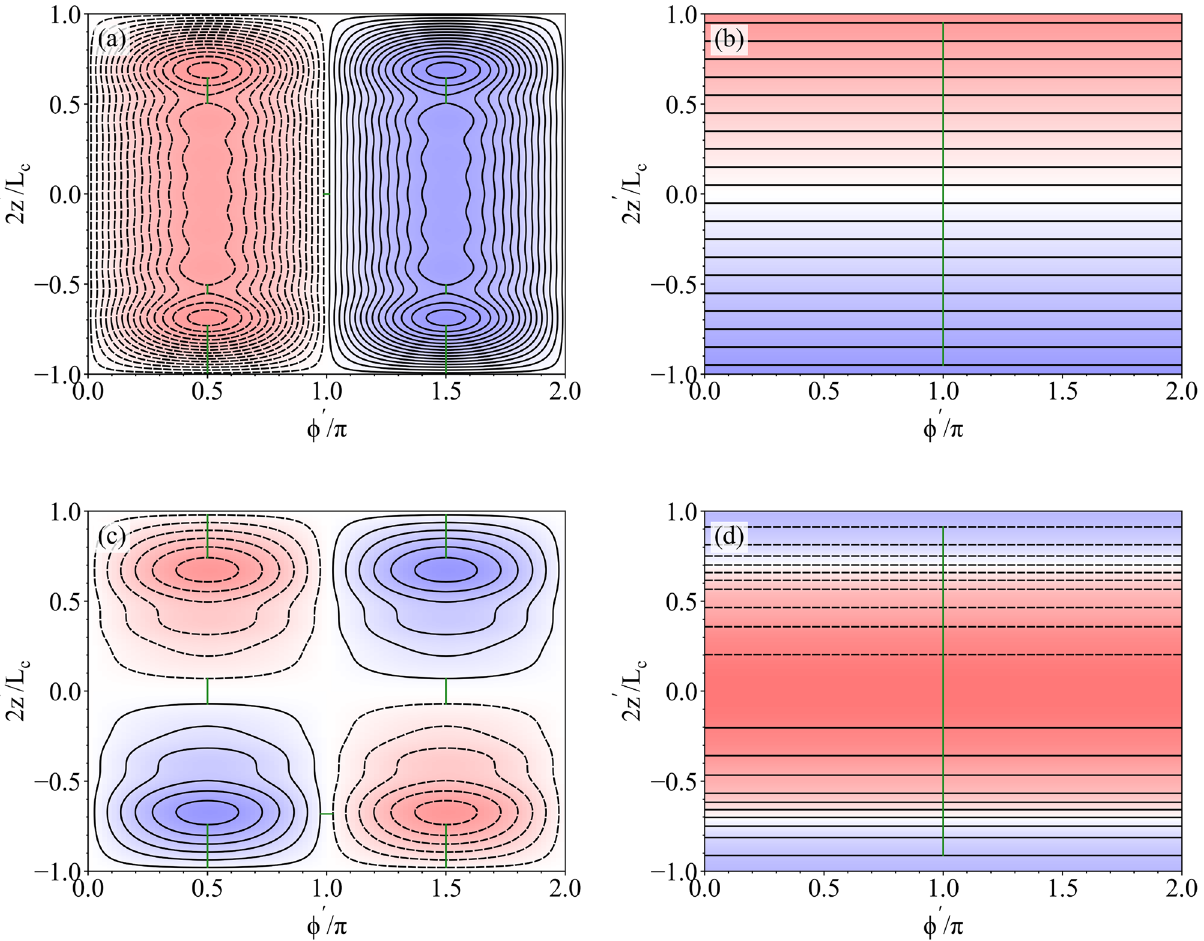
Figure 4. Normalised streamfunctions, calculated using Eq. (4), of the ( a ) uniform transverse field B x , ( b ) uniform axial field B z , ( c ) constant linear transverse field gradient d B x / d z , and ( d ) constant linear axial field gradient d B z / d z coils, respectively, on the surface of the coil former of length L c (blue and red shaded regions correspond to the flow of current in opposite directions and the intensity shows the streamfunction magnitude). Each streamfunction is contoured into streamlines (contour levels in Table 1) with solid and dashed black curves representing with opposite directions of current flow. To aid view, the uniform B z coil is represented with only 20 contour levels, whereas 400 are used in the real world design. Green solid wires show locations where the streamlines are joined with insulated entry and exit wires, following the direction indicated by the linestyles of the streamlines.